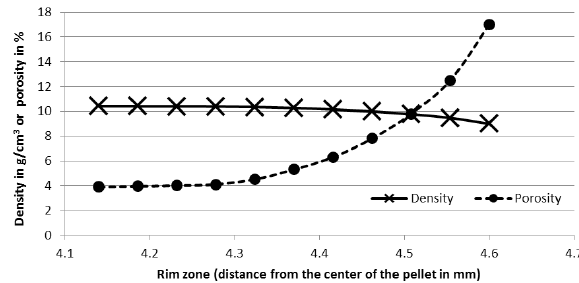
Figure 2: Density and porosity in the rim zone of a pellet derived for spent fuel of a burn-up of ~50 GWd t HM-1